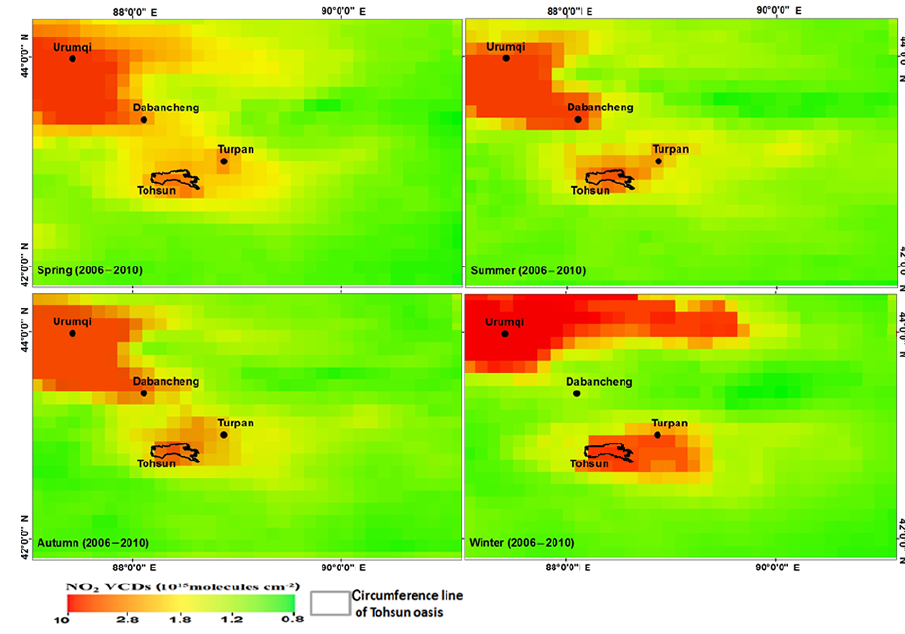
Figure 9. Seasonal 5-year-mean tropospheric vertical column densities of NO 2 (2006–2010); the “circumference line” represents the agri- culturally managed part of the Tohsun Oasis (230km 2